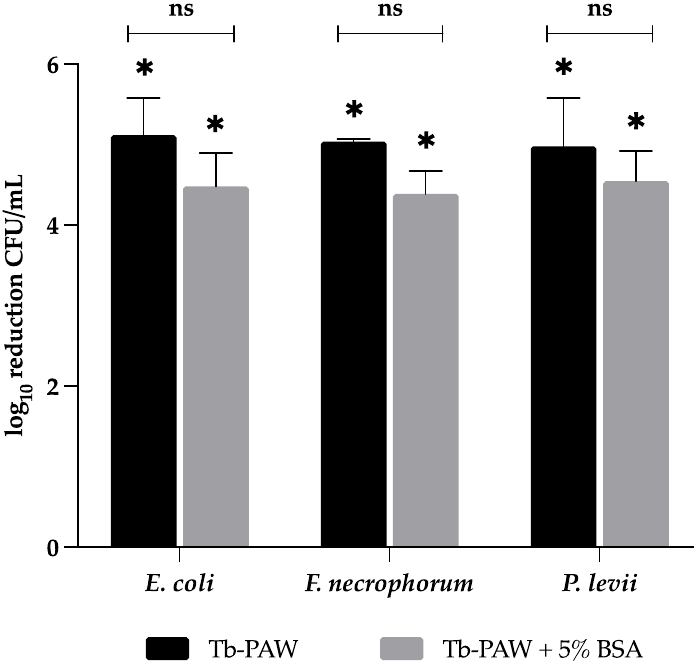
Figure 4. Comparison of the inactivation capacity of Tb-PAW on E. coli , F. necrophorum and P. levii under the influence of BSA. The treatment time for each bacterium was 1 min. Results represent the mean ± standard deviation. * Significant differences between the TRIS-buffer (control) and Tb-PAW samples are defined as p ≤ 0.05. Not significant differences between Tb-PAW and Tb-PAW with 5% BSA are defined as ns. ns = not significant; BSA = bovine serum albumin; Tb-PAW = TRIS-buffered plasma-activated